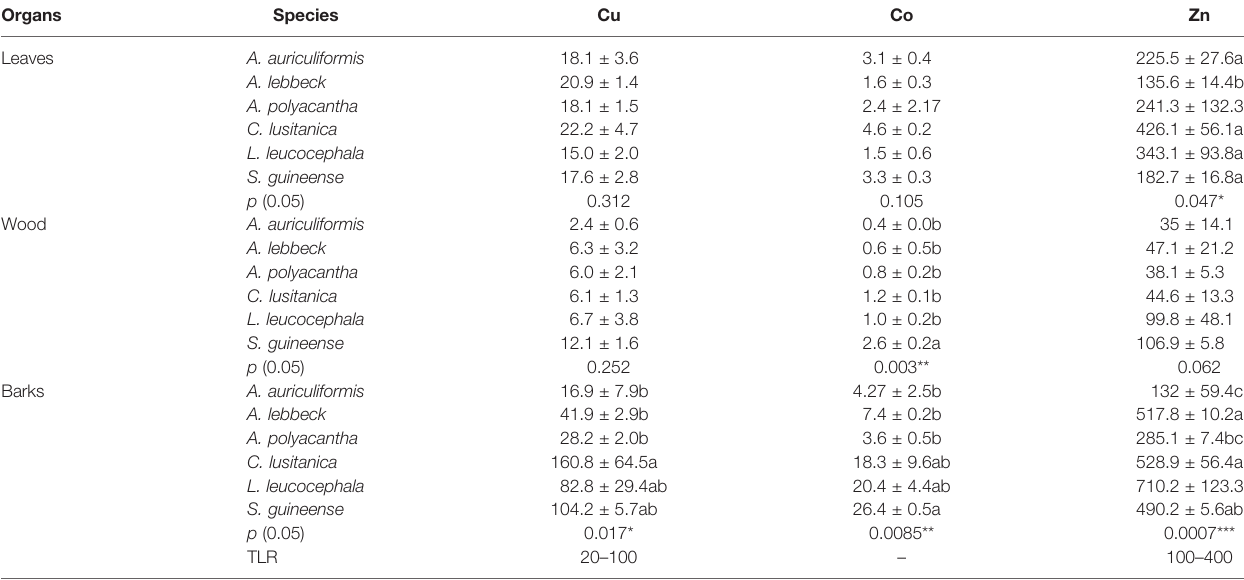
TABLE 6 | Trace metal concentration in organs according to the species and range of allowable concentration limits (mg kg − 1 dry